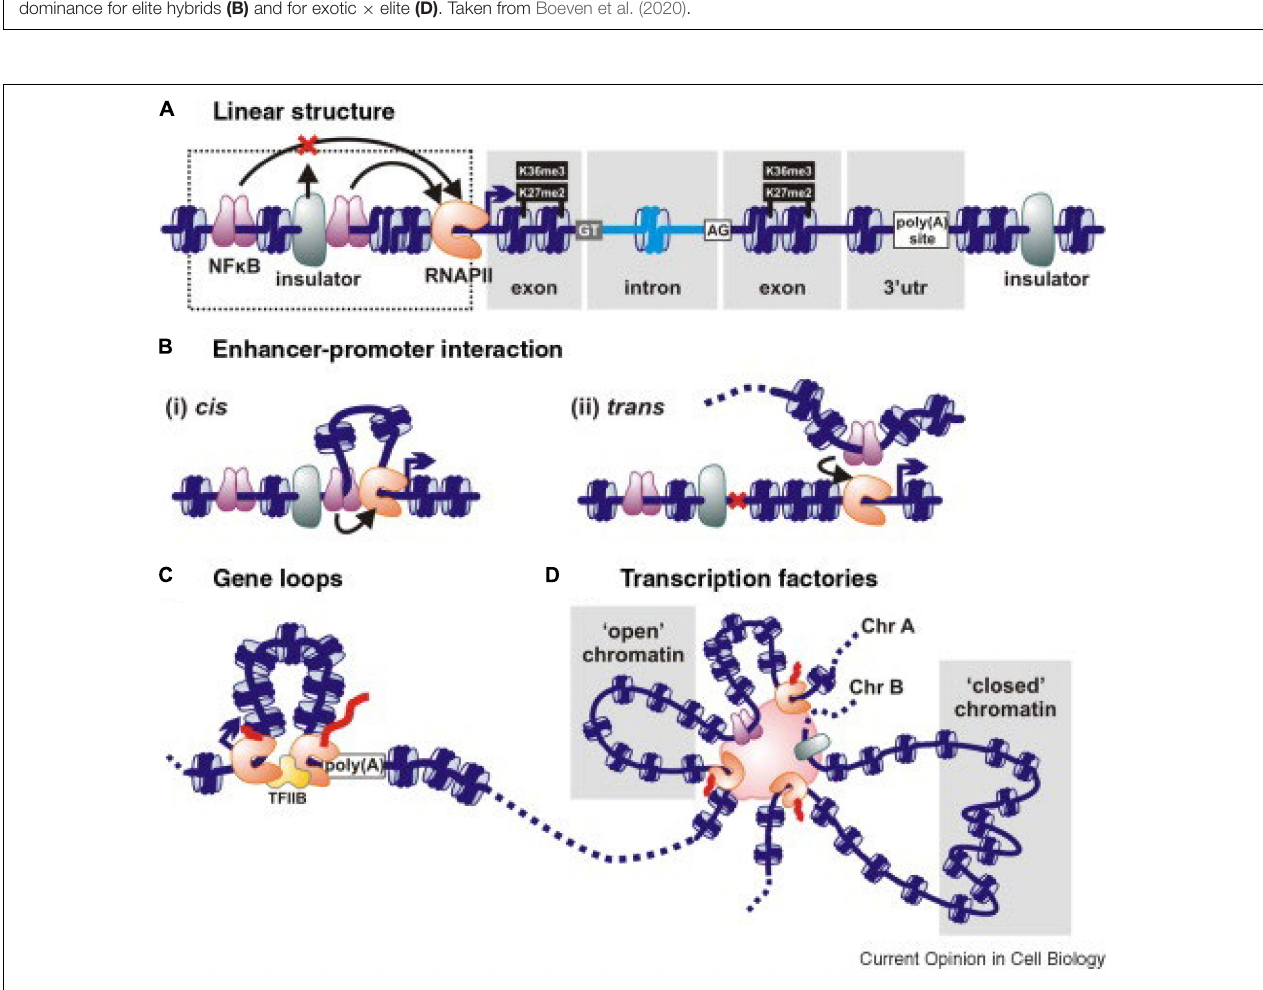
FIGURE 2 | Schematic interactions associated with gene transcription. (A) A linear representation of genetic elements including an insulator that prevents an upstream regulatory sequence NFkB affecting downstream gene expression. Histones in nucleosomes can be methylated at specific sites, as illustrated. DNA sequences can also be methylated at cytosine residues. (B) Enhancer–promoter interactions deployed in cis (i) to generate a local loop or in trans (ii) between chromosomes stimulate transcription. Nucleosomes are in blue, and transcription factors are in purple. (C) Gene loop. The 5 (cid:48) and 3 (cid:48) ends of an active gene are juxtaposed and tied by RNA polymerase (pink-brown) and/or transcription factors (TFIIB here). (D) A polymorphic transcription factory showing how transcription units on the same or different chromosomes (Chr) are bound through RNA polymerases or transcription factors. “Open” chromatin is transcribed when promoters in it attach to the factory; “closed” chromatin is remote from the factory and transcriptionally silent. The enhancers of multiple genes within the same transcription factory can come under the influence of any/some of the transcription factors concentrated in the factory. Taken from Papantonis and Cook (2010).